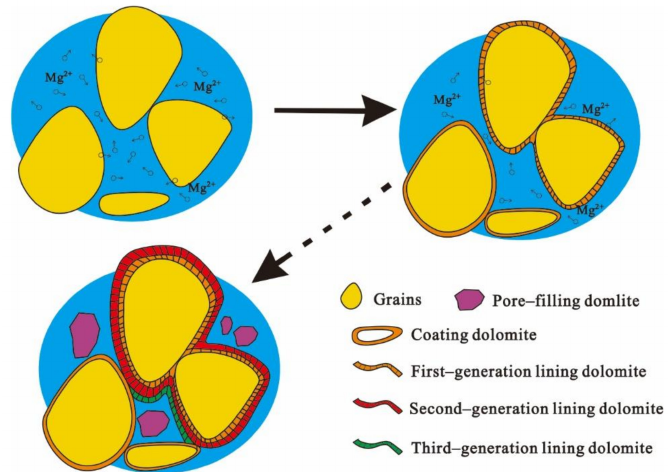
Figure 7. Origin of dolomite showing that with the consumption of Mg 2+ , the microcrystalline coating dolomite and the early lining dolomite precipitate formed. If sufficient Mg 2+ remained in the diagenetic fluid, pore-filling dolomite or late lining dolomite will be